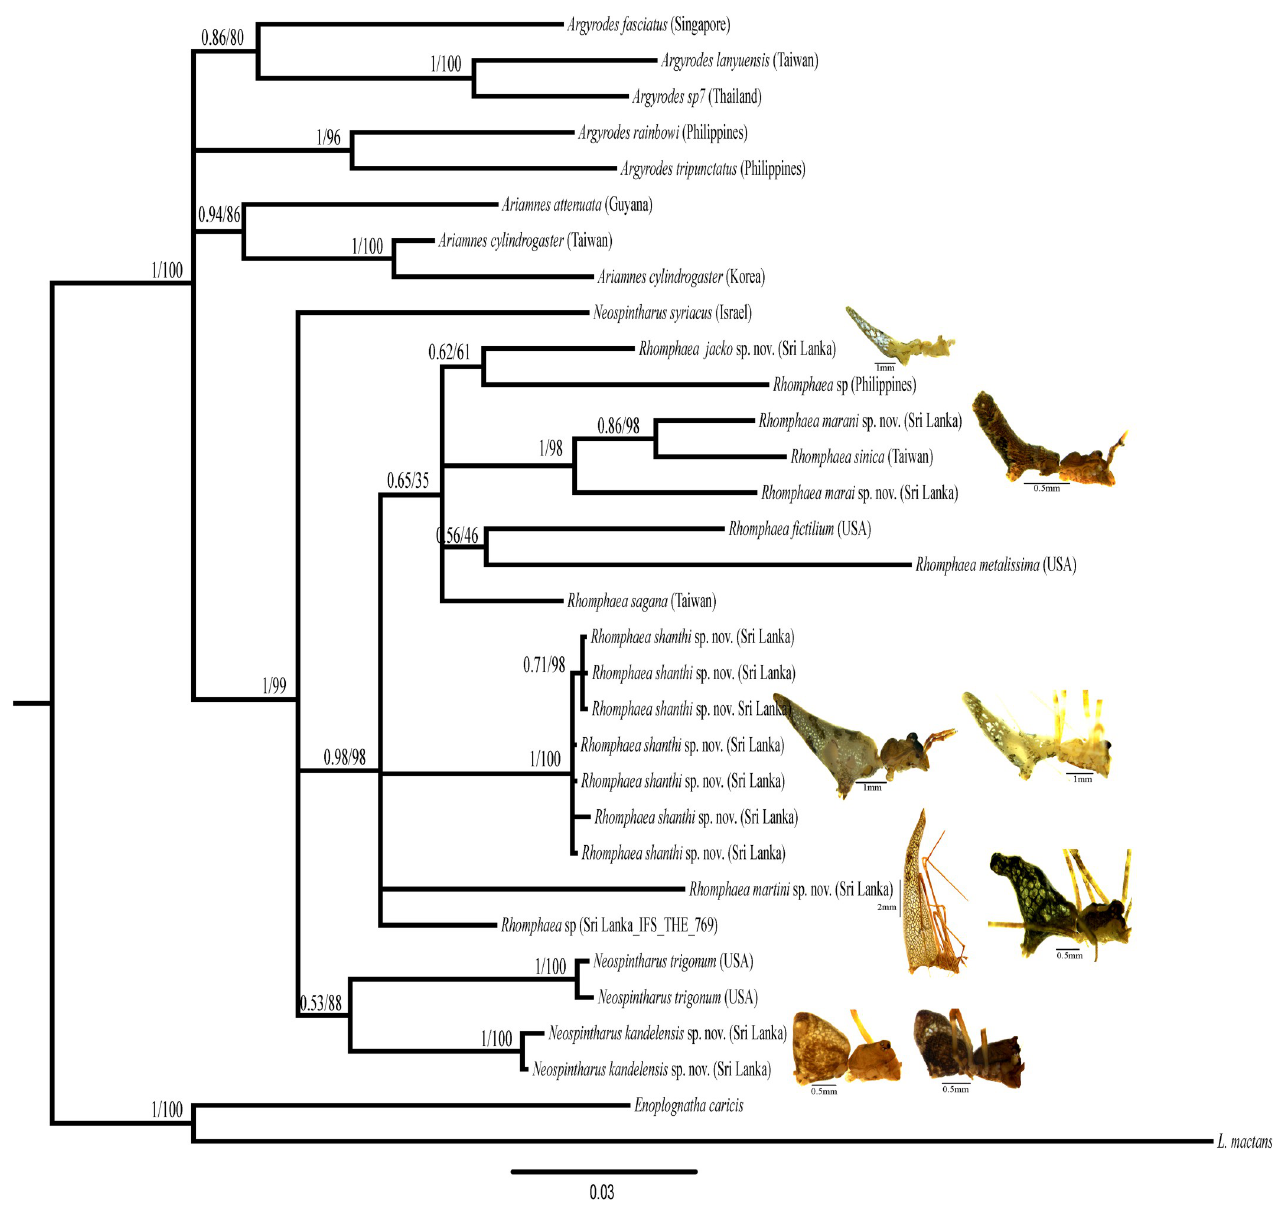
Fig 1. The phylogenetic tree inferred by Bayesian analysis of the combined molecular data ( COI , 16S and 28S ) in MrBayes. The numbers above nodes are posterior probability values / bootstrap values.